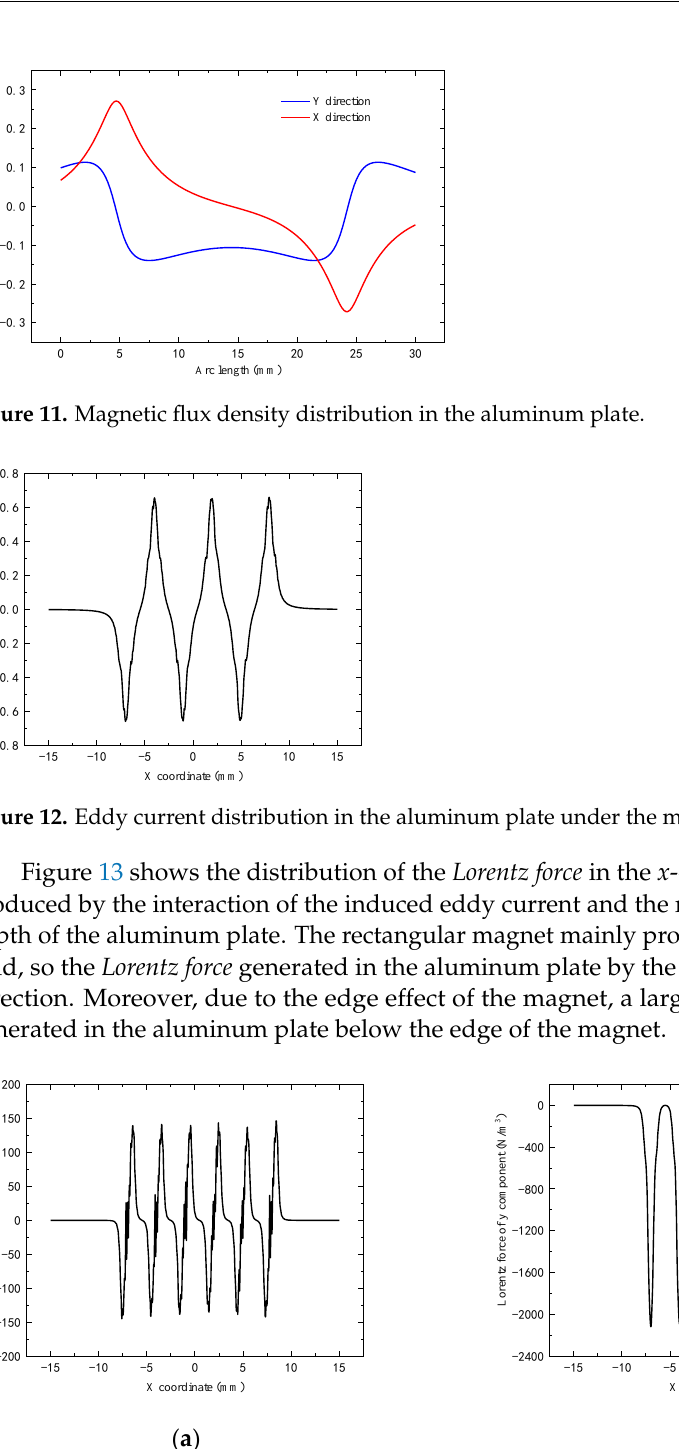
Figure 13. Lorentz force distribution in the aluminum plate under the magnet, ( a ) Lorentz force of x direction; ( b ) Lorentz force of y direction. Figure 14 shows the time-domain waveform of the EMUS signal received at point (200, −1 ). The first wave packet is the direct wave of the excitation signal, and the second